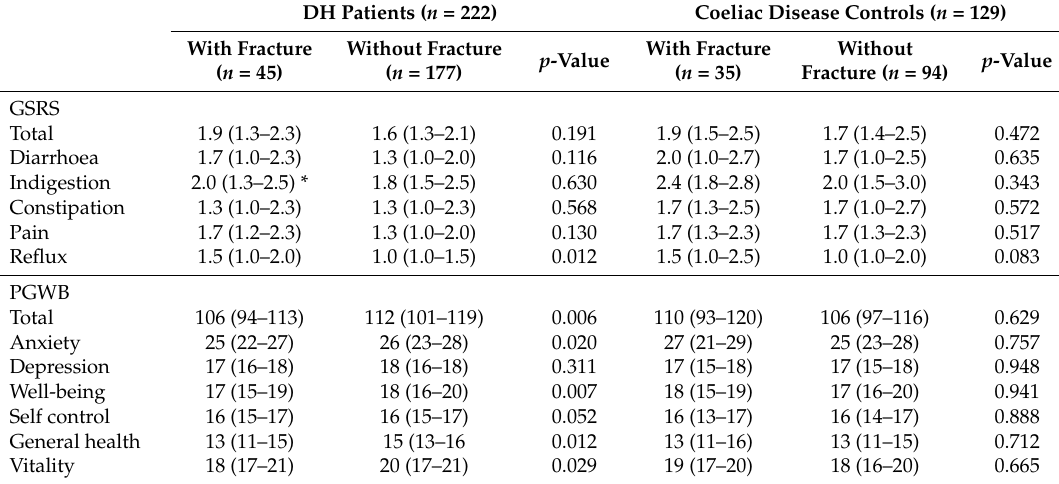
Table A1. Median values and interquartile ranges for the Psychological General Well-Being (PGWB) and Gastrointestinal Symptoms Rating Scale (GSRS) totals and subscores for the dermatitis herpetiformis (DH) patients and the coeliac disease controls with and without fractures. In the PGWB, a higher score indicates a better quality of life, and in the GSRS, a higher score indicates more severe